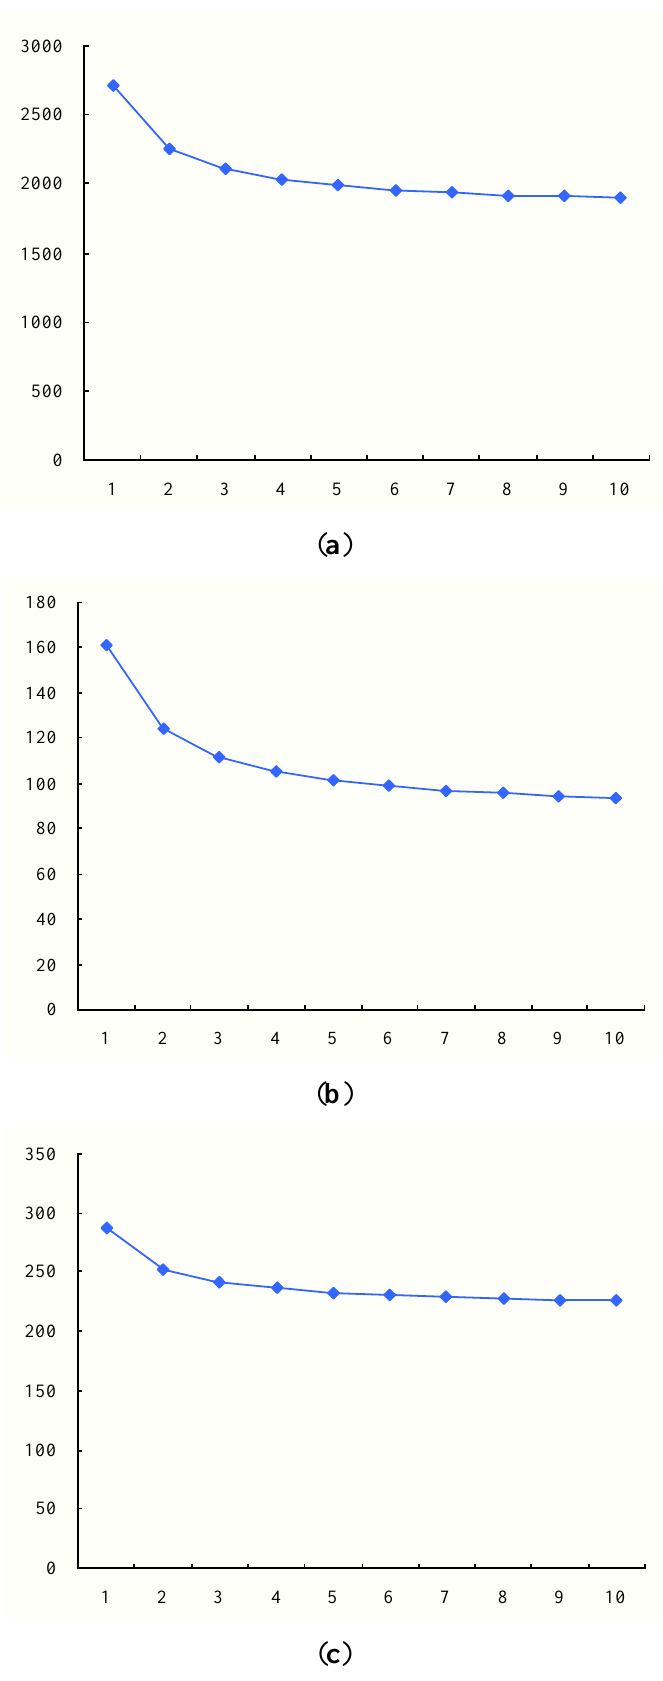
Figure 10. Results with four TDCs and different helicopter travel